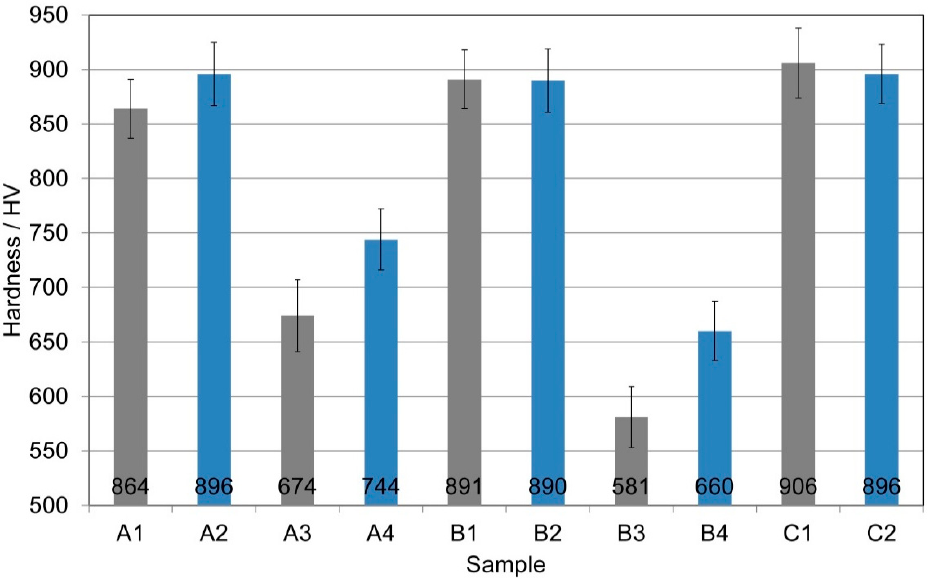
Figure 4. Hardness values of the high-speed steel samples with standard deviation error bars.